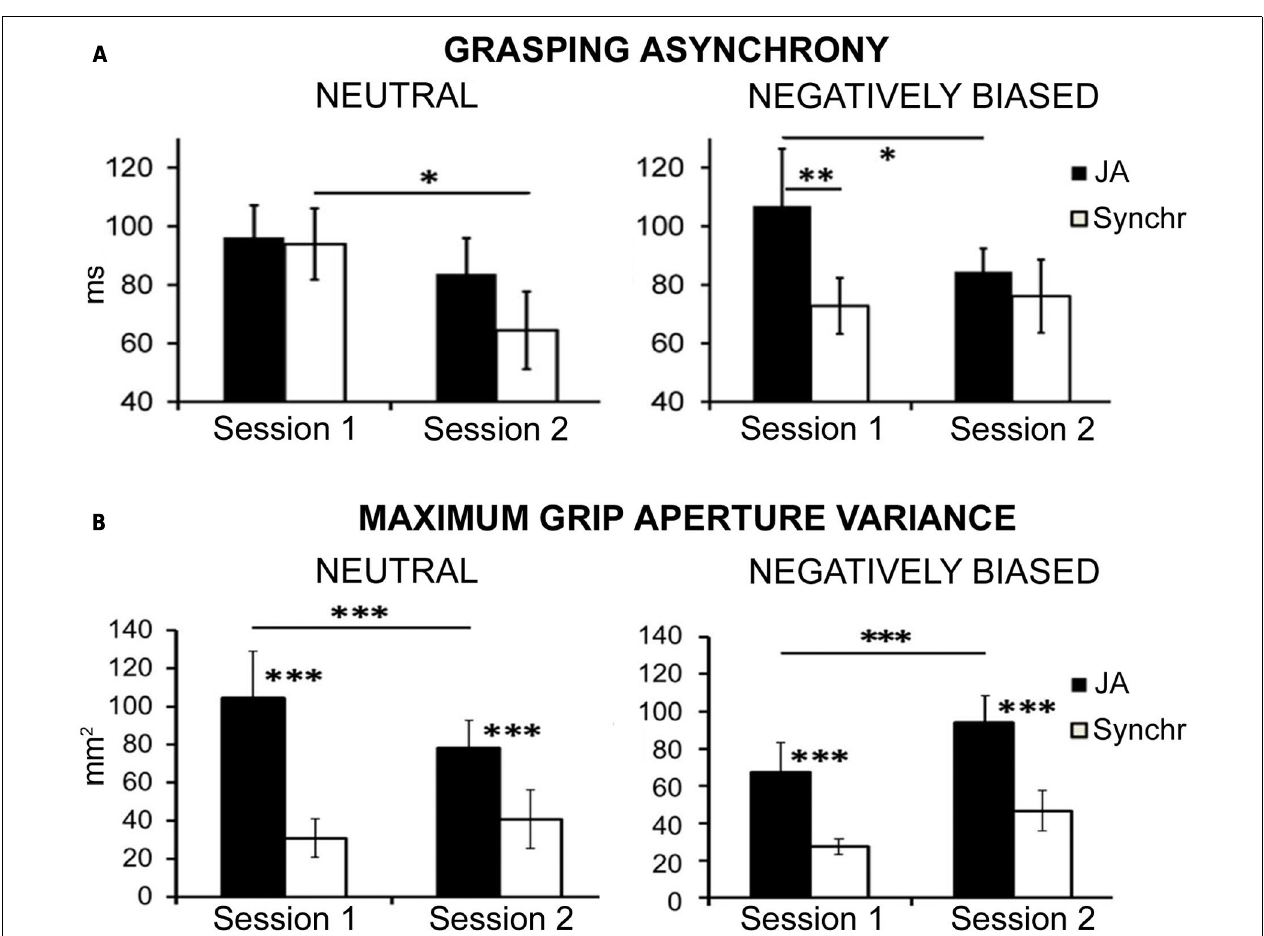
FIGURE 2 | Modified from Sacheli et al. (2012). The graphs illustrate results comparing behavioral performance in terms of grasping asynchrony (i.e., time-delay between partners’ grasp times on the bottle, A ) and grasping kinematics (in terms of maximum grip aperture variance, B ) of two groups of participants. In one group the interpersonal perception is left neutral (Neutral group), while in the other it is negatively biased (Negatively biased group). (A) In the Neutral group, participants initially (session 1) achieve the same level of performance in the synchronization (Synchr) and in the joint action (JA) condition. On the contrary, in the Negatively biased group, participants’ performance in JA is significantly lower (i.e., grasping asynchrony is higher, indicating poorer performance) than in Synchr: this suggests they are acting